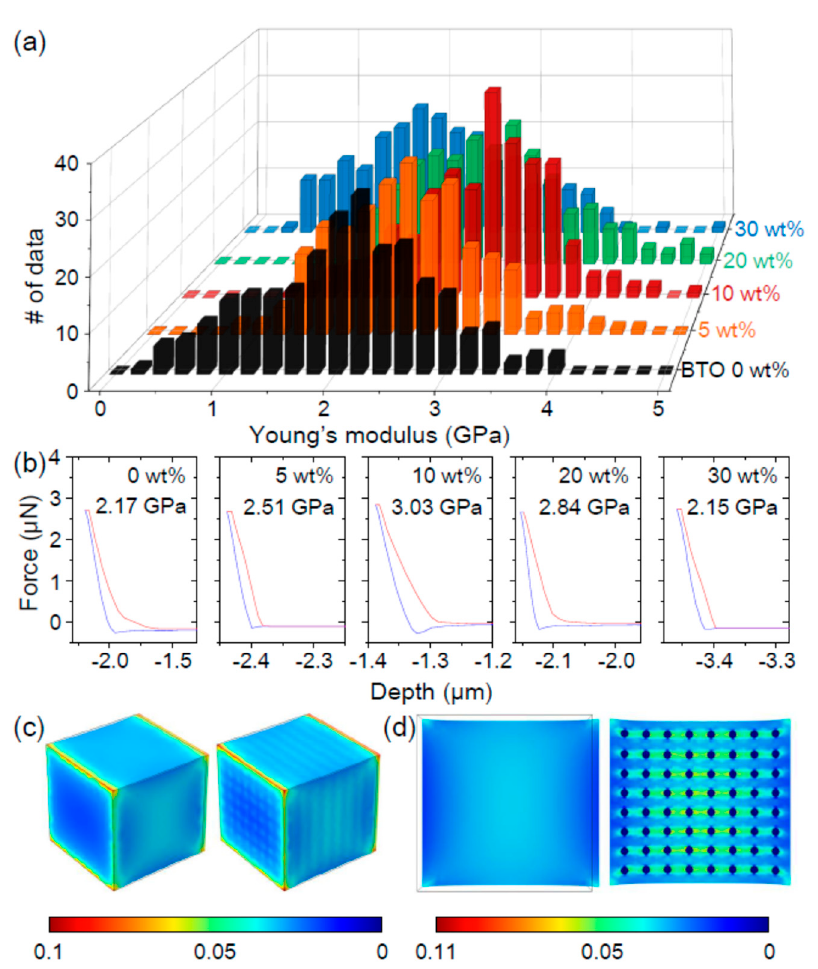
Figure 2. ( a ) Histogram of the Young’s modulus and ( b ) representative force–displacement curves. In ( b ), the red and blue lines represent increasing and decreasing applied force, respectively. Finite element simulations of the strain distribution ( c ) on the surface and ( d ) in the mid-layers of PVDF and PVDF–BTO blocks.